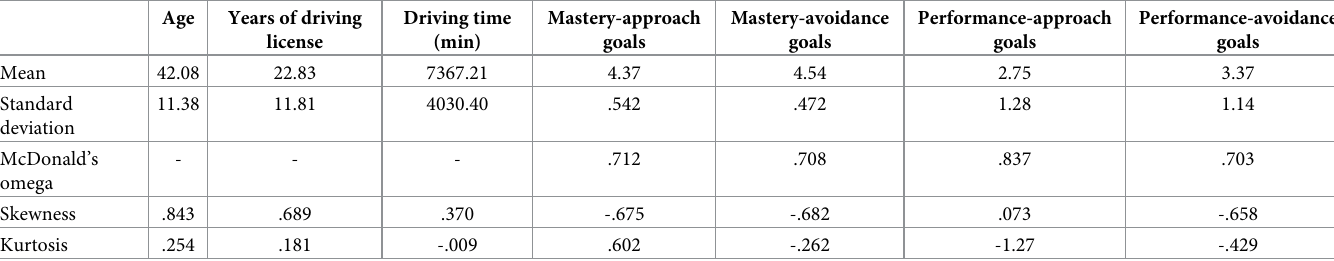
Table 1. Descriptive statistics of the final sample (without outliers), internal consistency, skewness, and